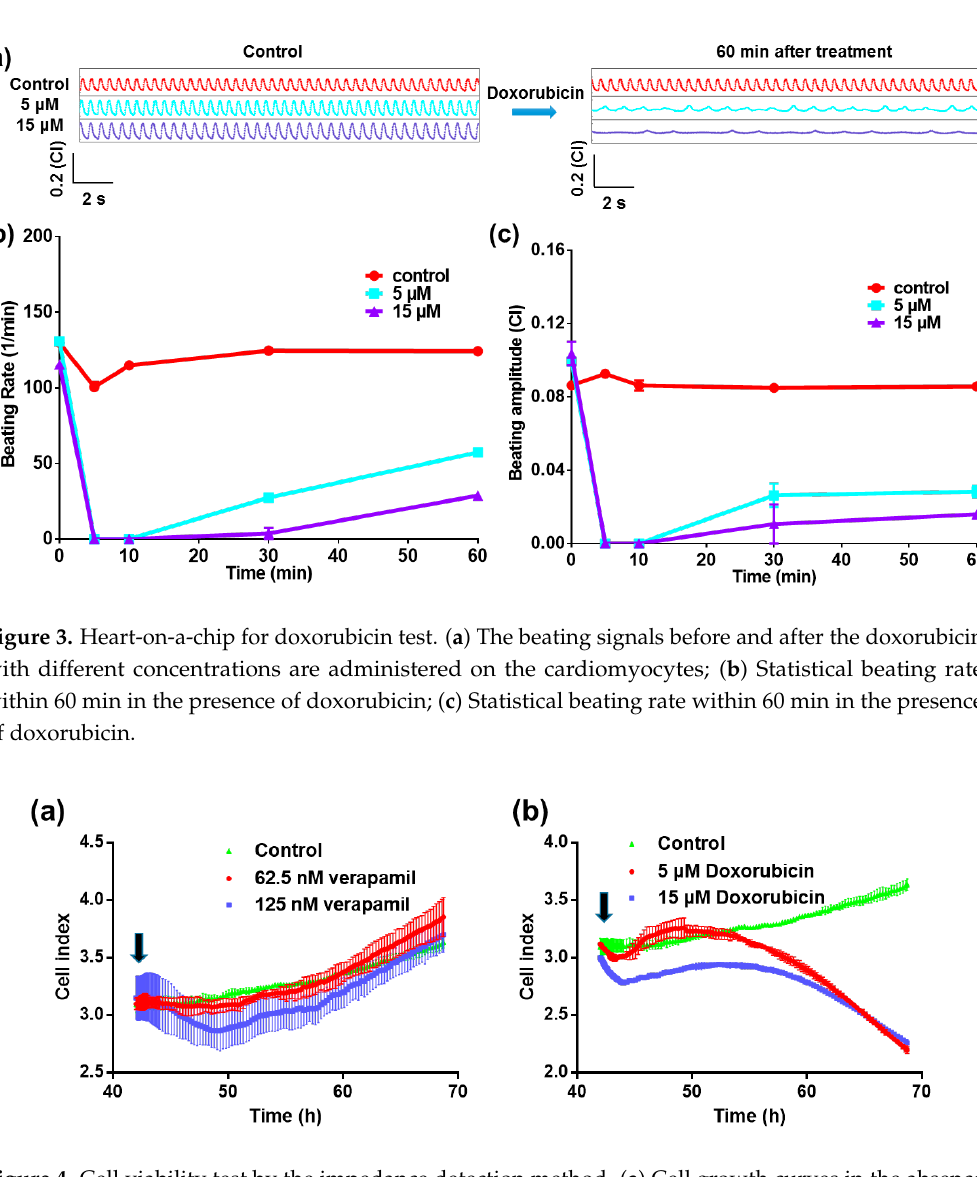
Figure 4. Cell viability test by the impedance detection method. ( a ) Cell growth curves in the absence and presence of verapamil; ( b ) Cell growth curves in the absence and presence of doxorubicin. Black arrows show the initial time of drug treatment.